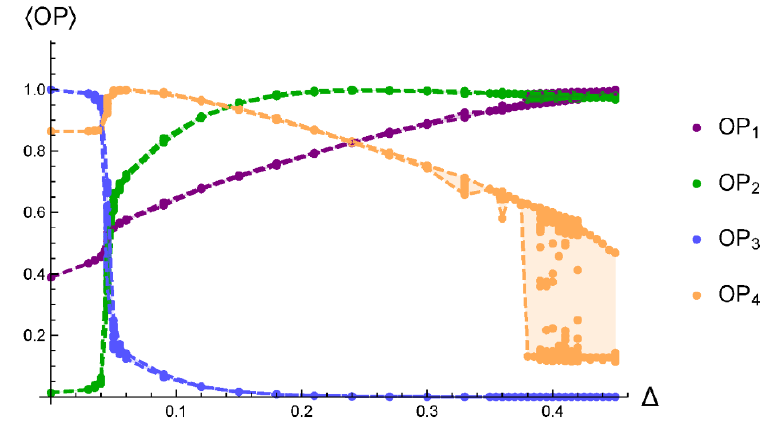
Figure 15 . Rescaled order parameters OP 1 , . . . , OP 4 in CDT with toroidal spatial topology ((cid:6) = T 3 ) measured for many di(cid:11)erent starting triangulations for each (cid:1) ( (cid:20) 0 = 2 : 0 is kept (cid:12)xed), the number of starting con(cid:12)gurations being di(cid:11)erent for various (cid:1). Each data point denotes h OP i measured from last 10 5 sweeps (or equivalently 10 12 attempted Monte Carlo moves), data from initial thermalization period were skipped. Shaded regions between the dashed lines denote the range of the measured data. Hysteresis is clearly visible for (cid:1) (cid:21) 0 : 38, especially for the OP 4 parameter which is the most sensitive to the bifurcation phase